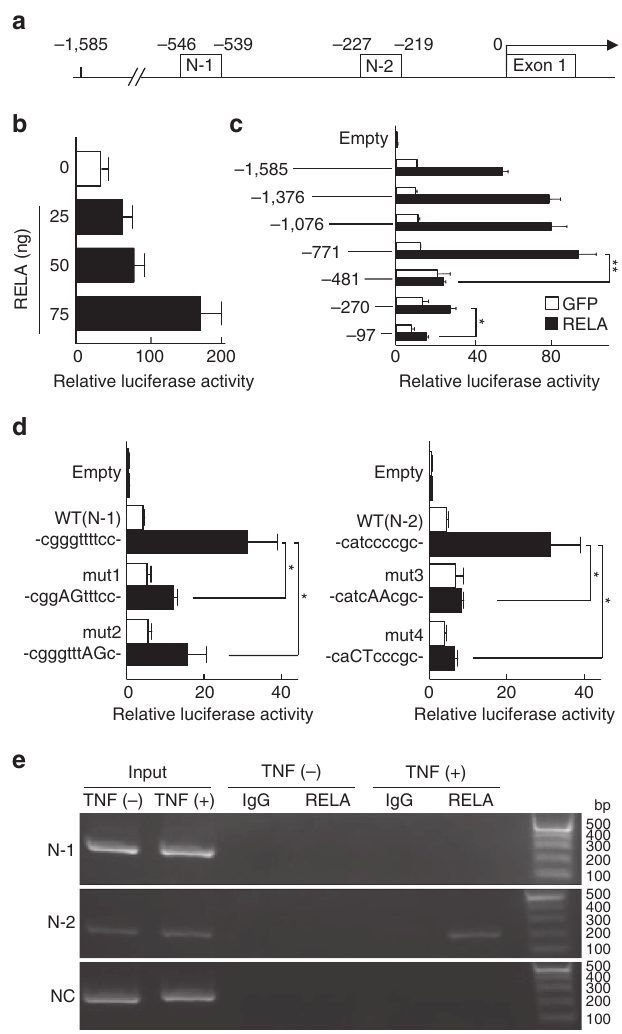
Figure 6 | Transcriptional regulation of PIK3R1 by RELA. ( a ) A proximal promoter region of the human PIK3R1 gene with two NF- k B consensus sequences, N-1 and N-2. ( b ) Luciferase activities resulting from RELA transfection of ATDC5 cells with a reporter construct containing a fragment of the PIK3R1 promoter ( (cid:2) 1,585 to 0bp relative to the transcription start site). Data are shown as means ± s.d. of three wells per group. ( c ) 5 0 -deletion analyses of the PIK3R1 promoter. Data are shown as means ± s.d. of three wells per group. * P o 0.05, ** P o 0.01; Student’s t -test. ( d ) Site-directed mutagenesis analysis of the PIK3R1 promoter fragment ( (cid:2) 1,585 to 0bp). Mut1 and mut2 are mutations of N-1, and mut3 and mut4 are those of N-2. Data are shown as means ± s.d. of three wells per group. * P o 0.05; Student’s t -test. ( e ) ChIP-PCR with lysates of OUMS-27 cells treated with or without TNF and amplified by a primer set spanning N-1 ( (cid:2) 593 to (cid:2) 408bp), N-2 ( (cid:2) 285 to (cid:2) 77bp) or not spanning both (NC, þ 55 to þ 289bp) before (input) and after immunoprecipitation with the anti-RELA antibody or nonimmune IgG. The images are representative of two independent